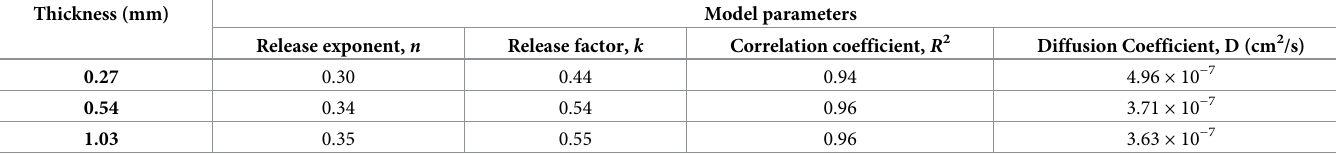
Table 1. Korsmyer Peppas model parameters for different thicknessess of SRF films for slow release of the